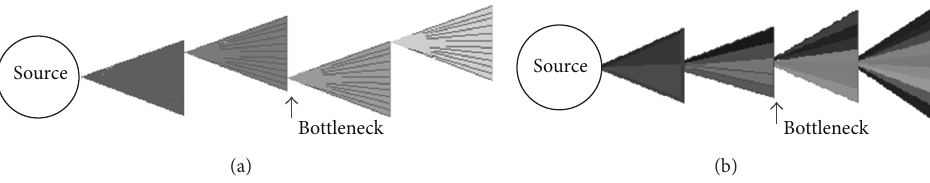
Figure 2: Accumulated genomic diversity expected from different passaging approaches. (a) Imposing a single cell genetic bottleneck at each passage step causes a gradual mutational shift with all descendent cells being closely related to one another. (b) By passaging a random subset of microbes at each step, accumulated mutational diversity within the lineage population is expected to be much